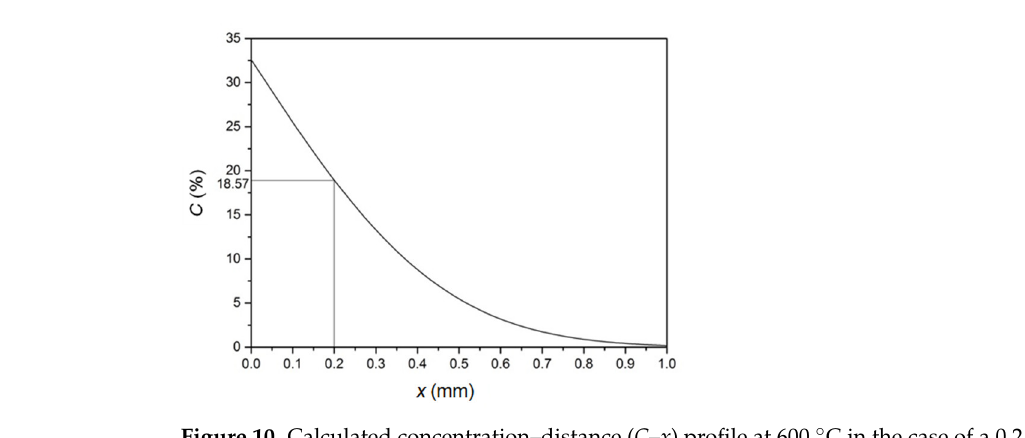
ness of the Sn-rich layer. of the Sn-rich layer.